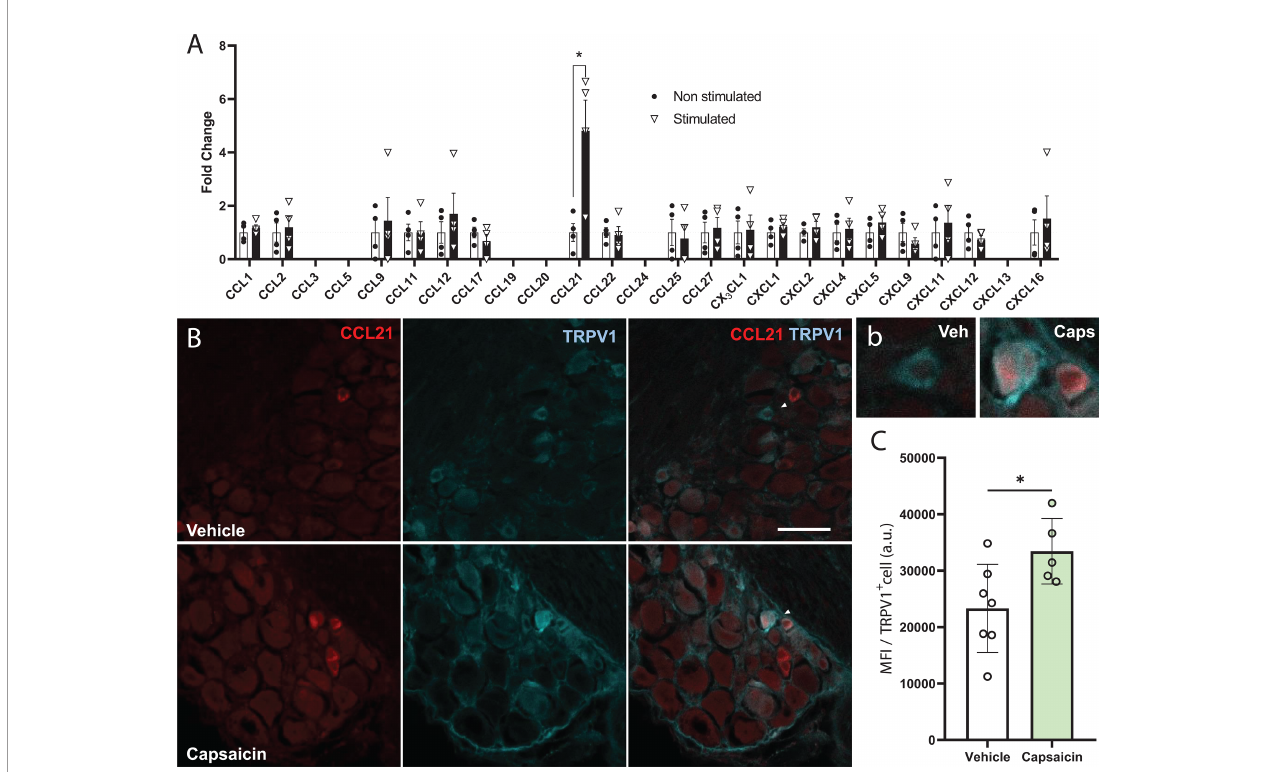
FIGURE 1 | CCL21 is upregulated upon TRPV1 + nociceptive neuron activation. (A) Chemokine array data shows that only CCL21 expression was increased after optogenetic stimulation. CCL3, CCL5, CCL19, CCL24 and CXCL13 were not detected. Data are expressed as mean fold change of normalized array spots intensity ± s.e.m, Multiple Student ’ s t-test; * p < 0.05 (n=4). (B) Immunohistochemistry showing CCL21 expression in TRPV1 + neurons 2h after vehicle or capsaicin i.pl. injection. White arrows: magni fi ed neurons in (b) Scale bar: 50 m m. High magni fi cation inset. (C) Intraplantar capsaicin injection increased CCL21 expression in TRPV1 + nociceptors speci fi cally as shown by mean fl uorescence intensity (MFI) of TRPV1 + cells. a.u., arbitrary units. Data are expressed as mean ± s.e.m; Student ’ s t-test; * p < 0.05; n=5-7